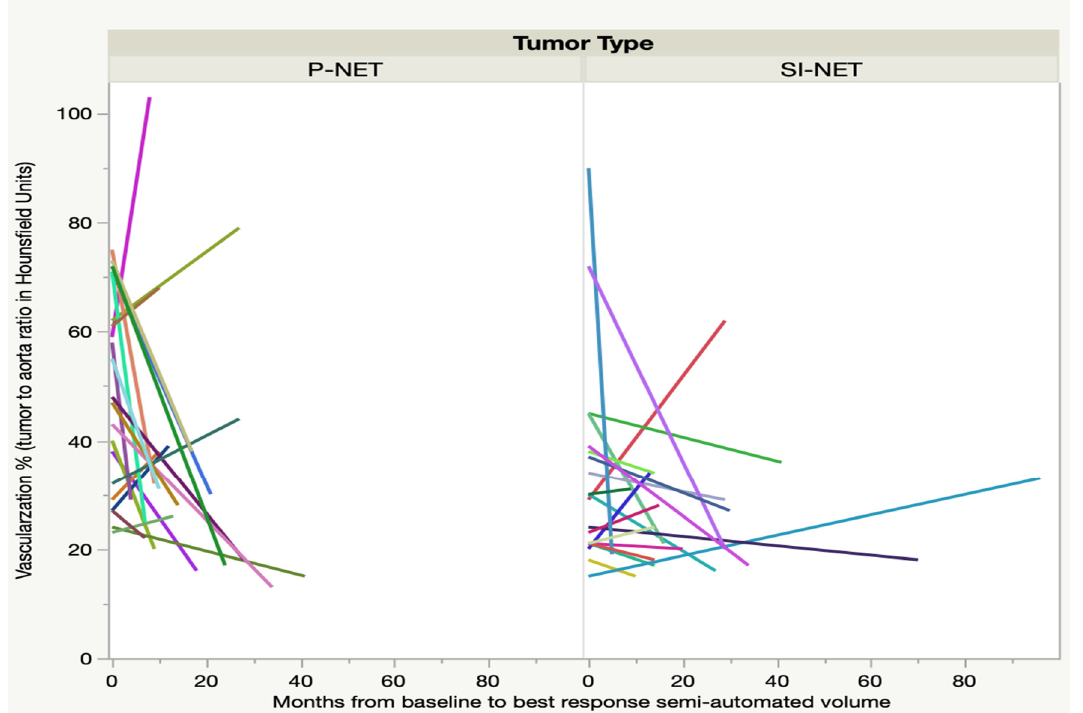
Figure 1. Fractional change ( ∆ %) of the tumor to aorta ratio (as an indication of tumor vascularization) from CT at baseline to best response, as regards fractional semi-automated volume. Each line represents one tumor.